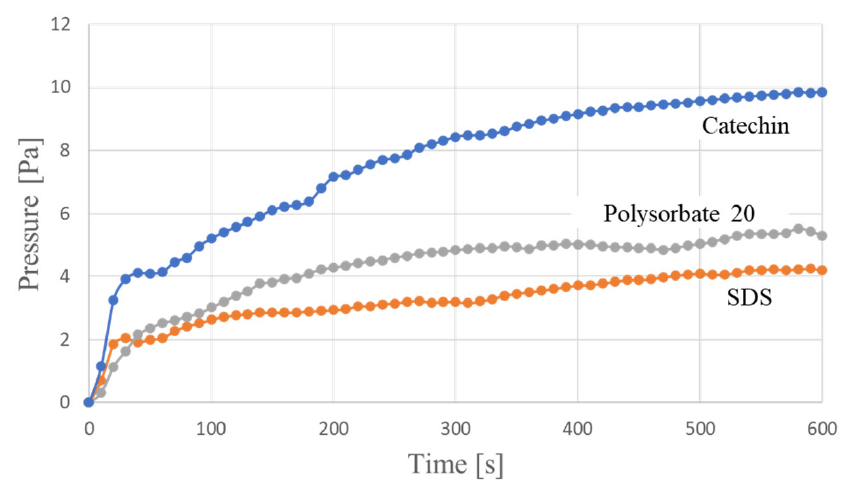
Figure 6. Structure of dispersants ( a ) SDS, ( b ) polysorbate 20, and ( c ) catechin.